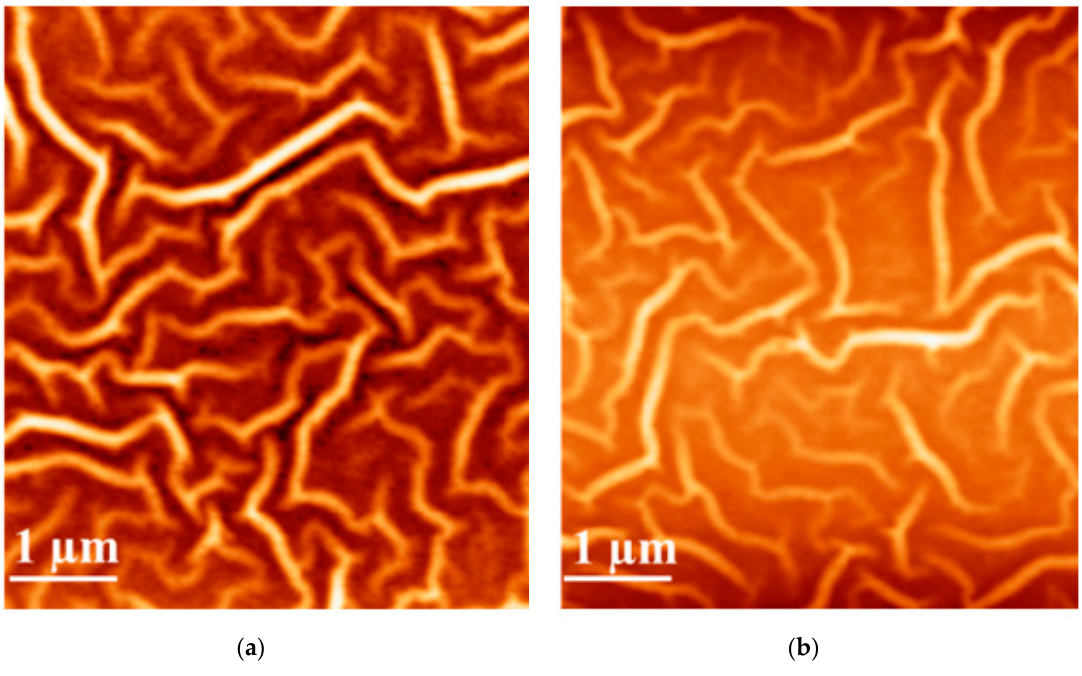
Figure 3. The AFM top view images of ( a ) without SVA treatment and ( b ) with SVA treatment.